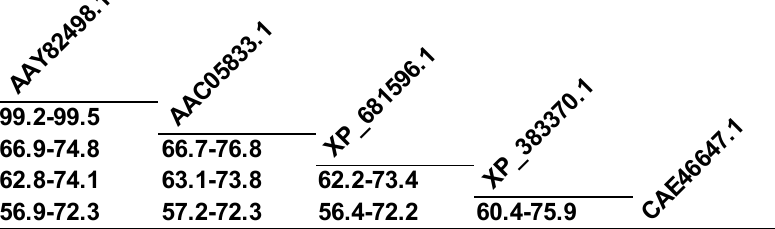
Table 3. global identities and similarities of Dh EP. global alignments of putative translated Dh EP CAE46647.1 with the following entries of fungal polygalacturonases: AAY82498.1 from Ophiostoma ulmi ; C05833.1 Ophiostoma novo-ulmi ; XP_681596.1 from Aspergillus nidulans ; XP_383370.1 from Gibberella zeae . Identity/similarity values were calculated by means of